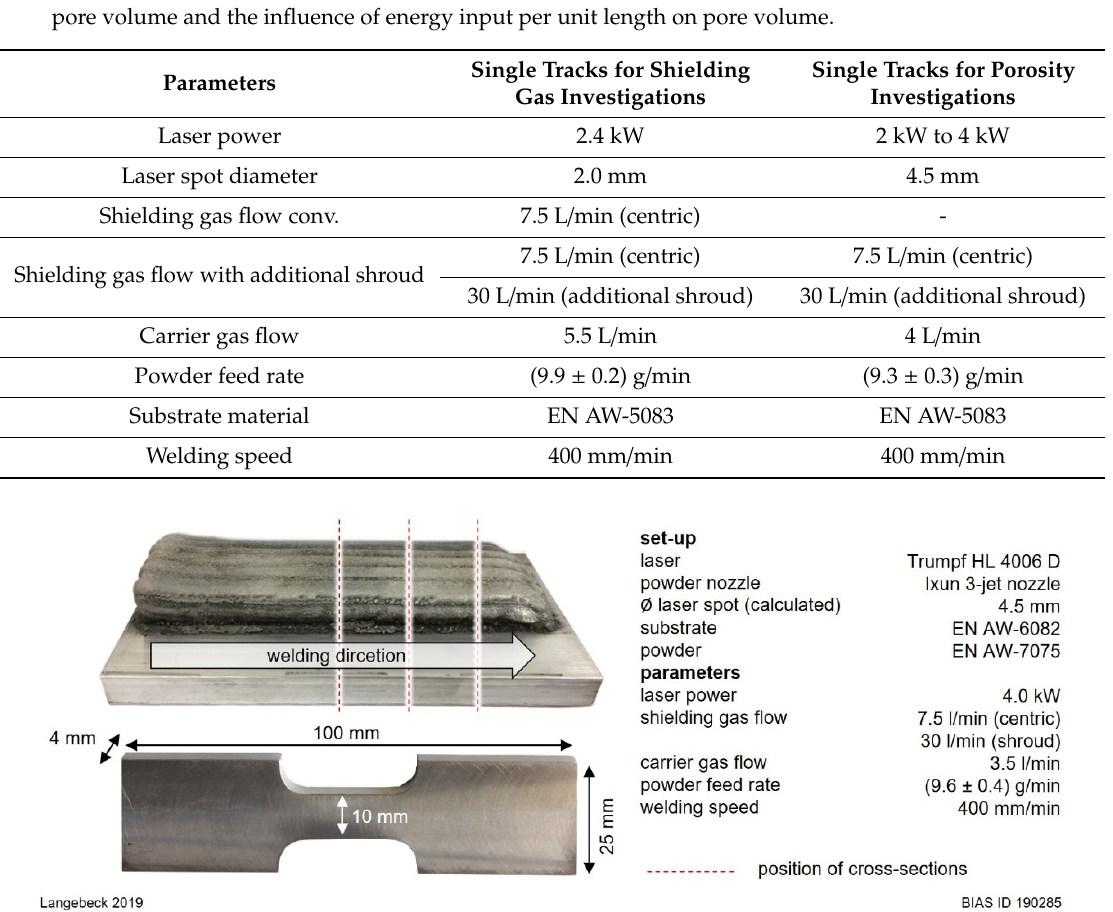
Table 2. Process parameters for single tracks to determine the influence of shielding gas concept on pore volume and the influence of energy input per unit length on pore volume.